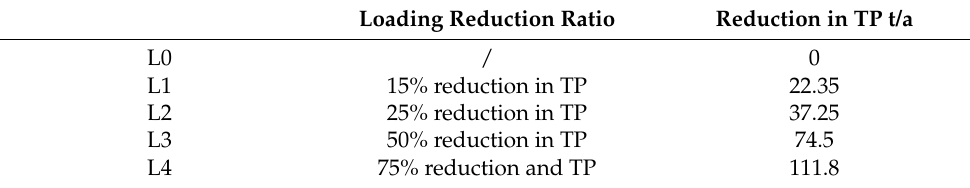
Table 3. Four reduction scenarios under the existing watershed loading